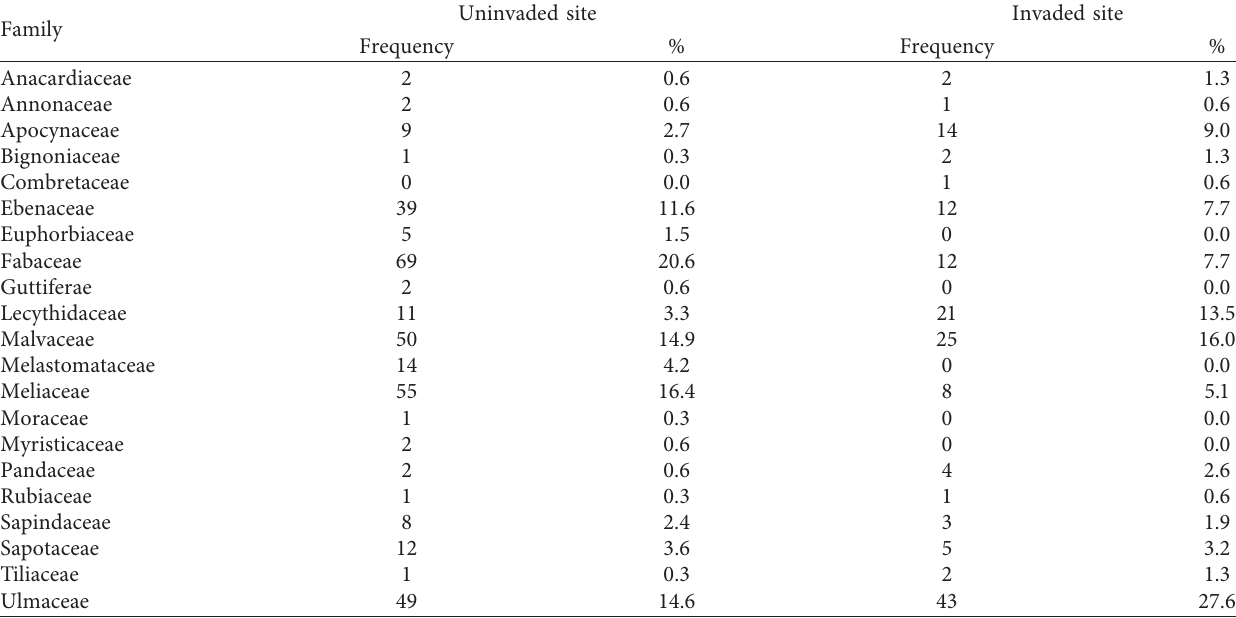
Table 3: Family distribution of naturally regenerated tree species on study